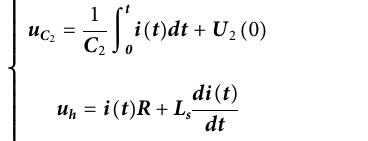
FIGURE 4 Disconnector breaking no-load